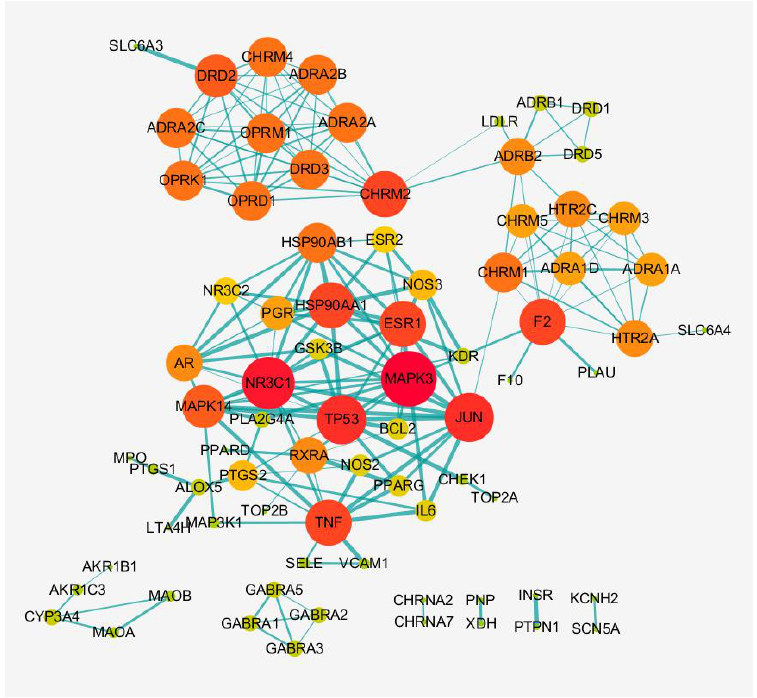
Figure 2. The protein–protein interaction (PPI) of 82 targets.